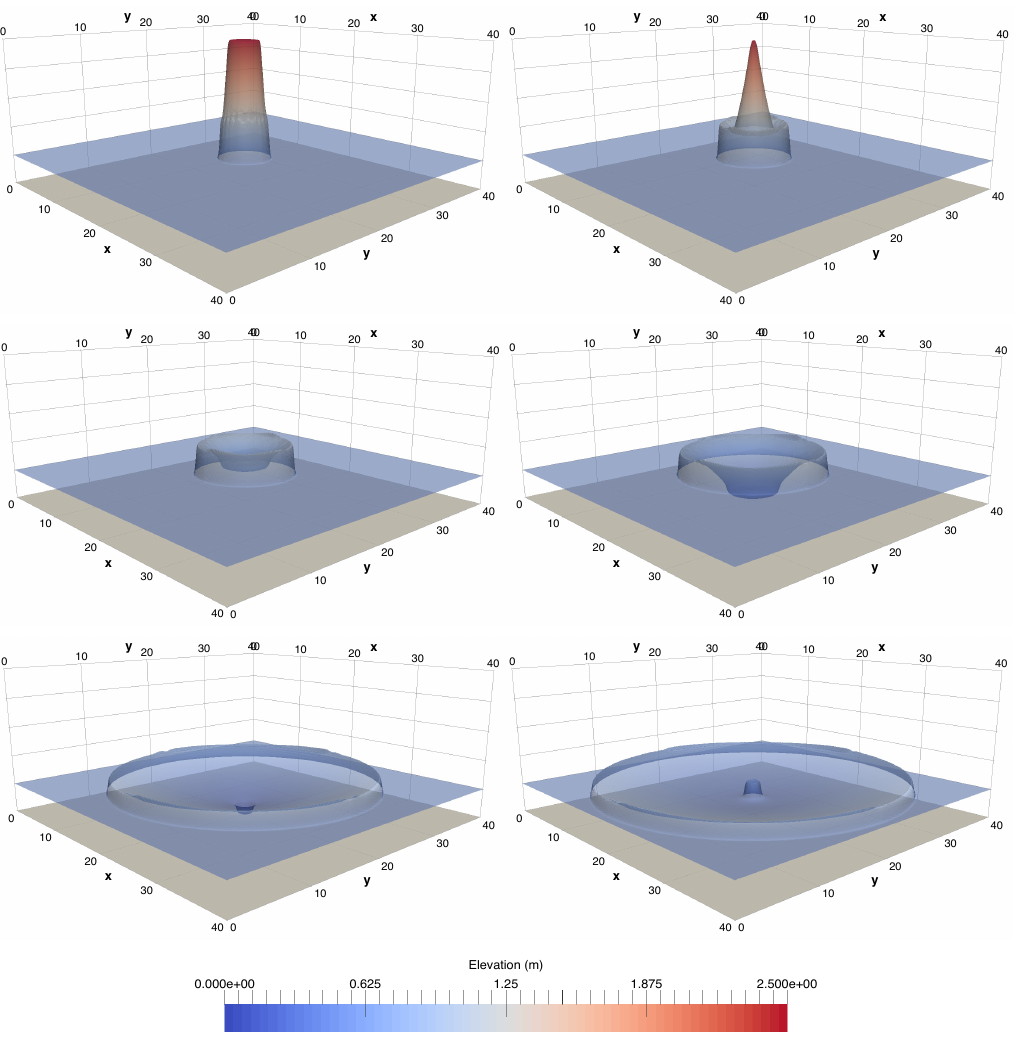
Figure 5. Case 1: results of the central-upwind (CU) scheme at 0.1, 0.4, 0.8, 1.6, 3.8, and 4.7 s.